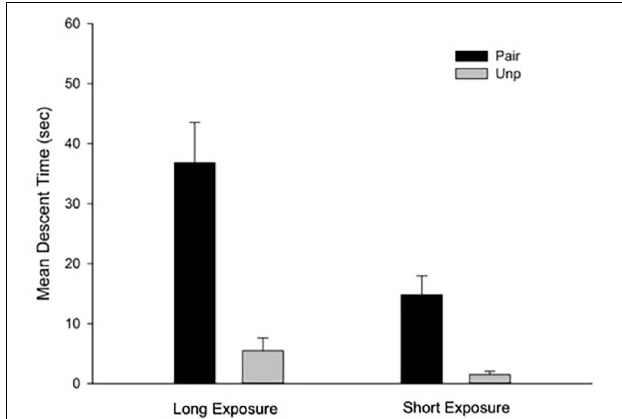
FIGURE 2 | Mean descent latency for the drug-free test trial as a function of Groups for the free-drug test trial. Pair: Paired; Unp: Unpaired. Error bars represent